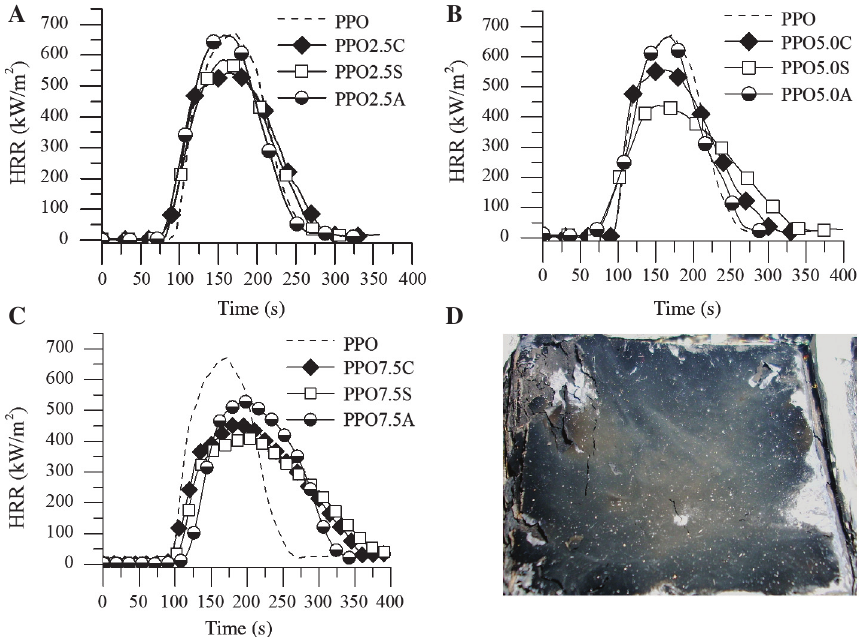
Figure 7 Comparison between the HRR curves of PPO and of the composites containing (A) 2.5 wt% of filler, (B) 5.0 wt% of filler, (C) 7.5 wt% of filler. (D) Digital image of the surface of PPO7.5S after the cone calorimeter test.